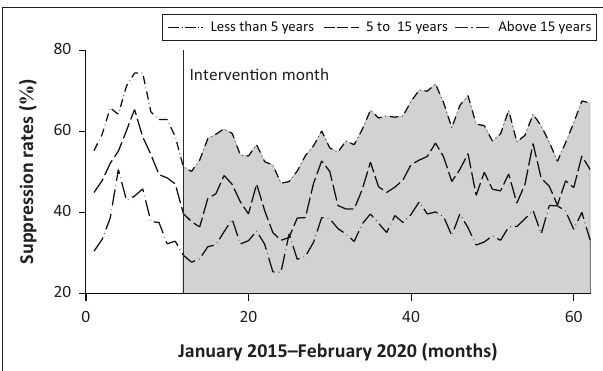
FIGURE 3: Proportions of those virally suppressed before and after the 90-90-90 strategy implementation.